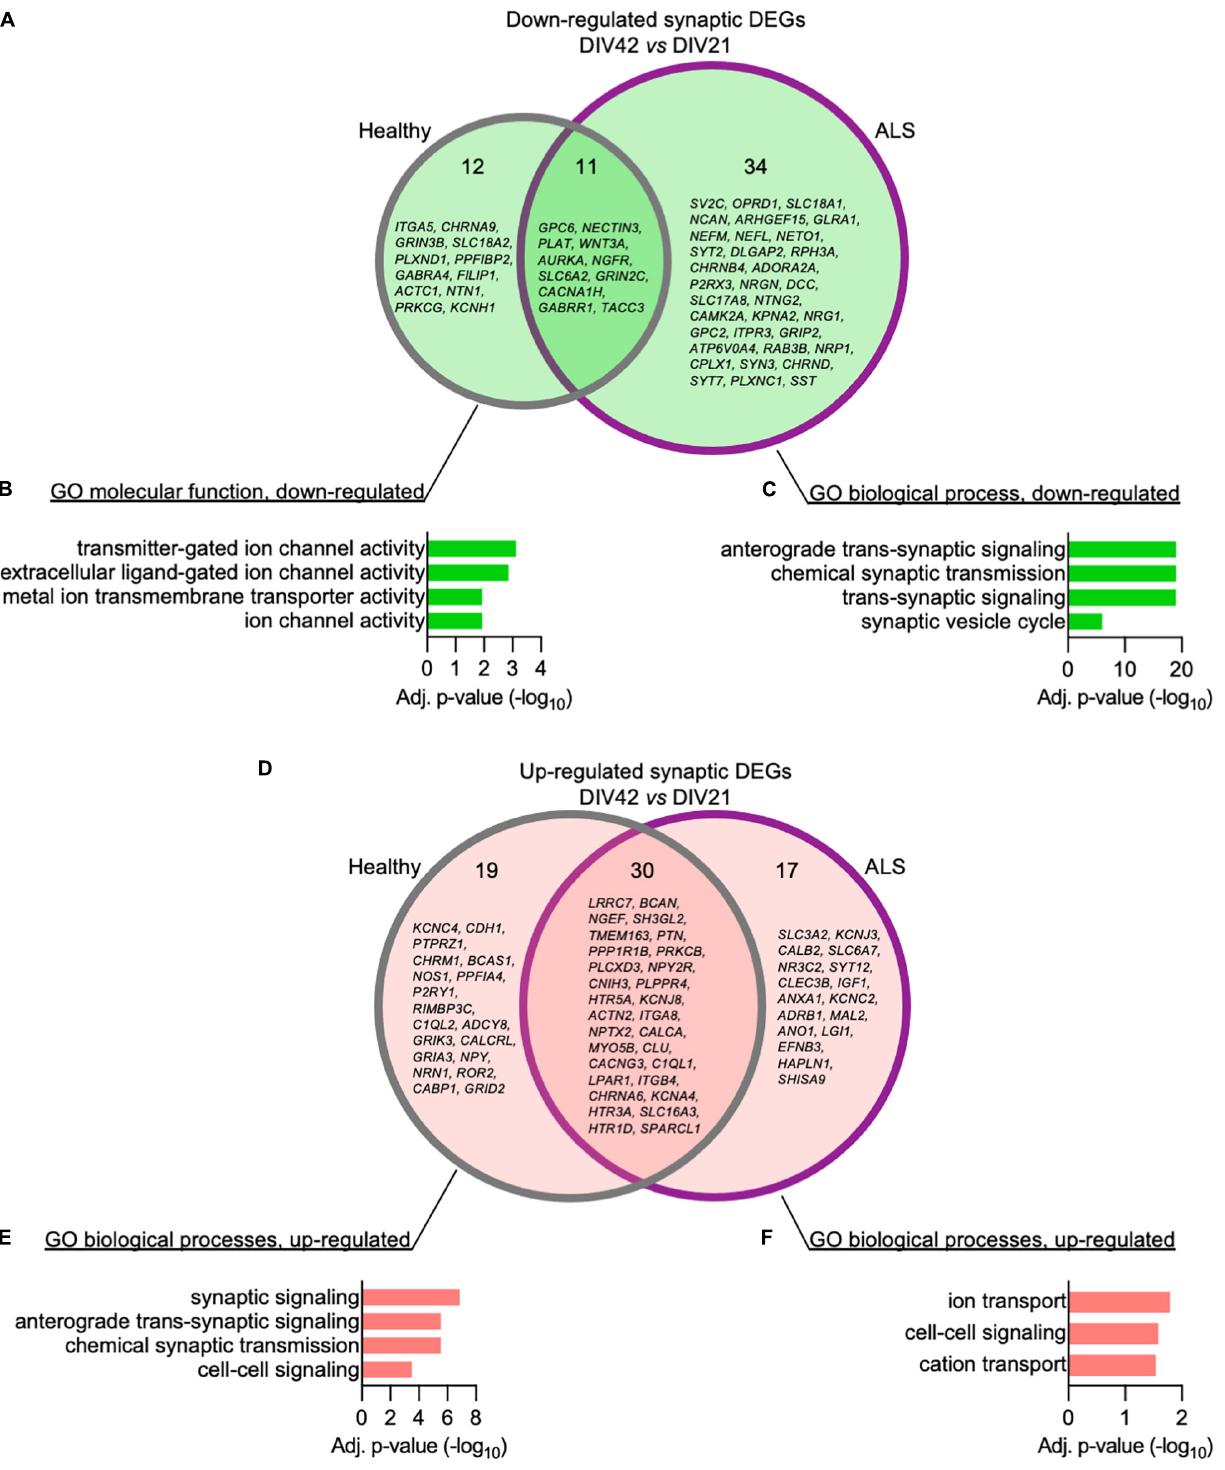
Frontiers in Molecular Neuroscience |